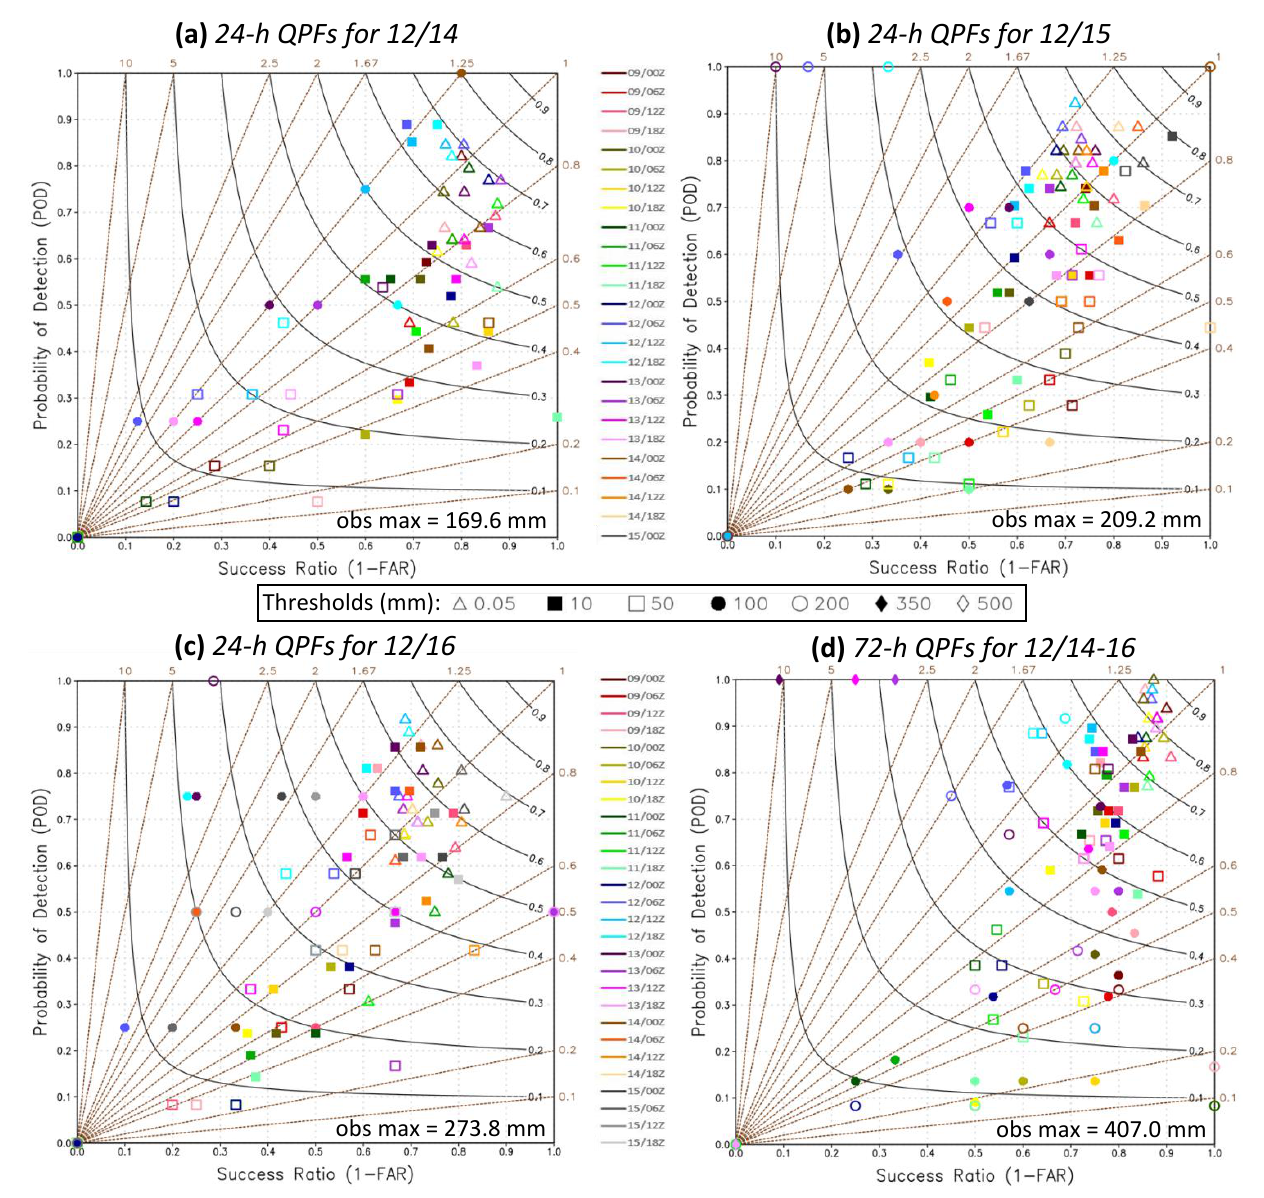
Figure 14. As in Figure 9, except for 24 h QPFs targeted for ( a ) 14, ( b ) 15, and ( c ) 16 December 2015 (in UTC), and ( d ) 72 h QPFs for the combined period (of 14–16 December) during Melor at six selected thresholds from 0.05 to 350 mm, plus 500 mm in ( d ).